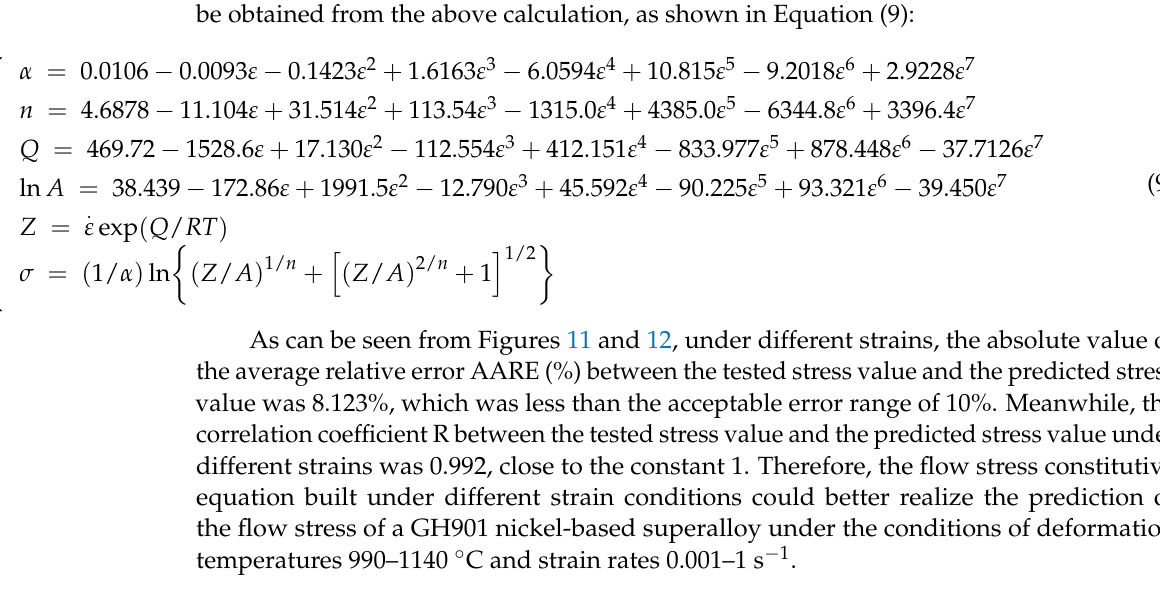
As can be seen from Figures 11 and 12, under different strains, the absolute value of the average relative error AARE (%) between the tested stress value and the predicted stress value was 8.123%, which was less than the acceptable error range of 10%. Meanwhile, the correlation coefficient R between the tested stress value and the predicted stress value under different strains was 0.992, close to the constant 1. Therefore, the flow stress constitutive equation built under different strain conditions could better realize the prediction of the flow stress of a GH901 nickel-based superalloy under the conditions of deformation temperatures 990–1140 ◦ C and strain rates 0.001–1 s − 1